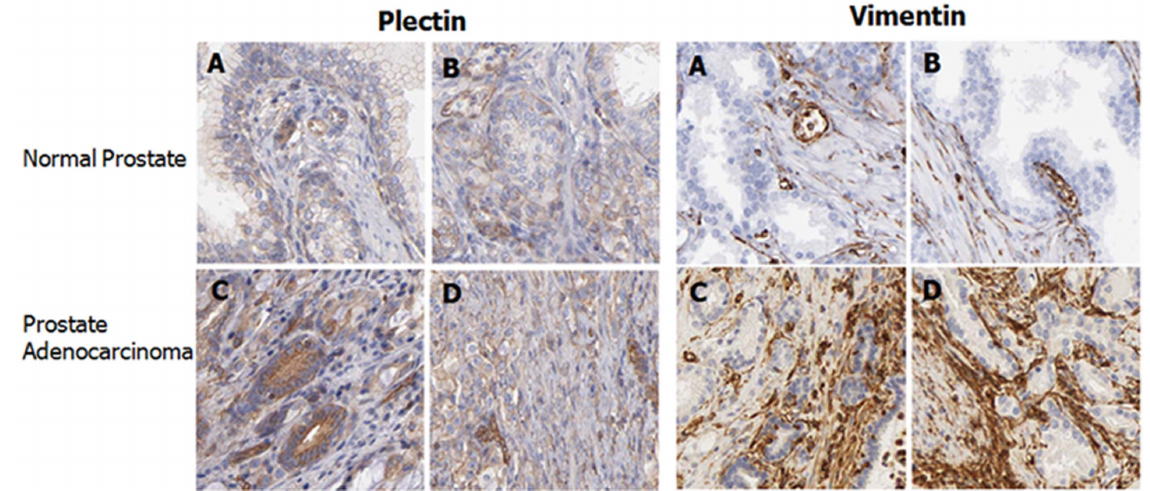
Figure 9. Representative images showing the immunoexpression of plectin and vimentin in prostatic tissue. The Human Protein Atlas was used to screen for the expression of plectin and vimentin focusing on immunohistochemistry of normal (upper panels A and B) and cancerous prostate tissue (lower panels C and D). Immuno-expression of both plectin and vimentin are higher in the malignant adenocarcinoma tissues compared to the normal